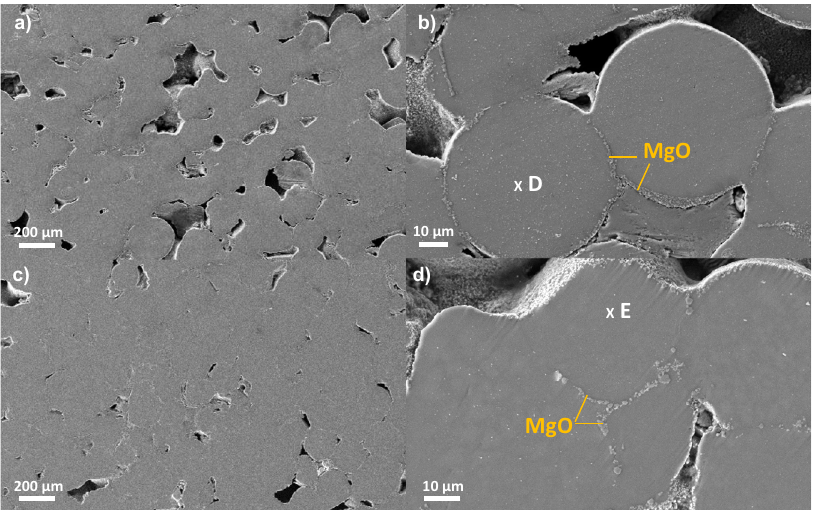
Fig. 2 Surface morphology of Mg-Zn-Zr alloys from BJP additive manufacturing. SEM images of a , b BJP-73 sintered at 573 °C and c , d BJP- 87 sintered at 615 °C with different eventual